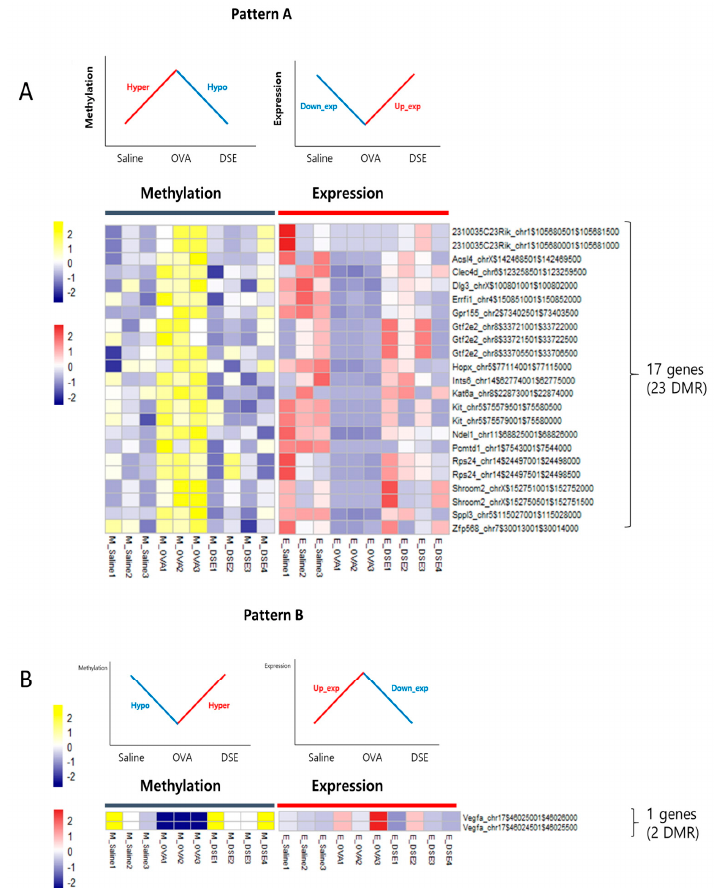
Figure 4. Anti-asthmatic pattern genes with inverse correlation between methylation and expression. Matched heat map of DNA methylation and gene expression profiling in hyper/hypo methylated and down/upregulated genes ( A ). Matched heat map of DNA methylation and gene expression in hypo/hyper methylated and up/downregulated genes ( B ).